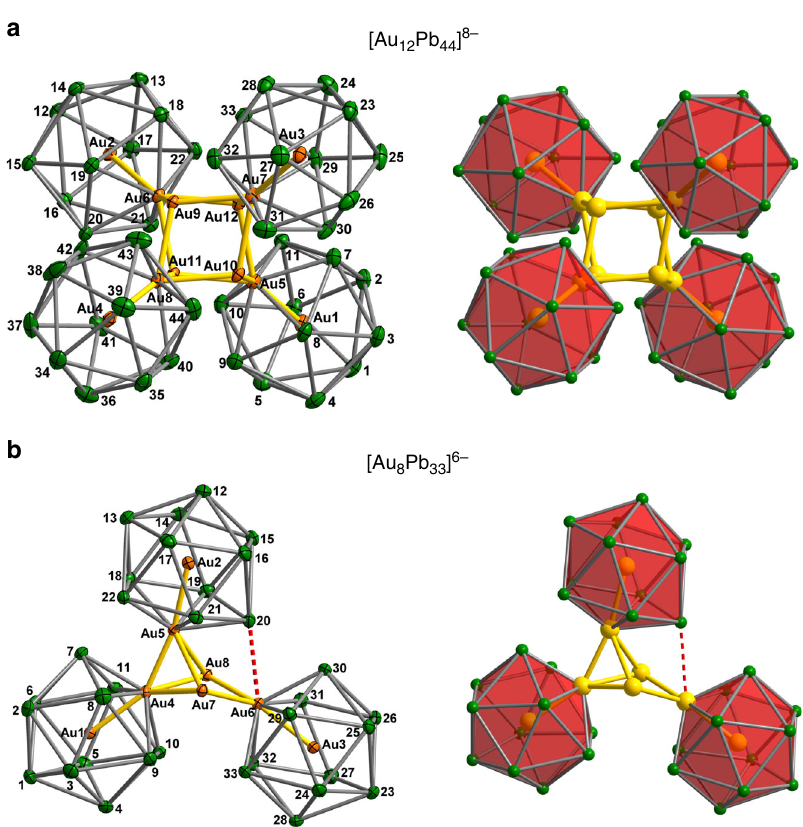
Fig. 3 Structures of [Au 12 Pb 44 ] 8 − and [Au 8 Pb 33 ] 6 − . a Structure of the [Au 12 Pb 44 ] 8 − anion in 3 . b Structure of the [Au 8 Pb 33 ] 6 − anion in 2 . Thermal ellipsoids are set at the 50% probability